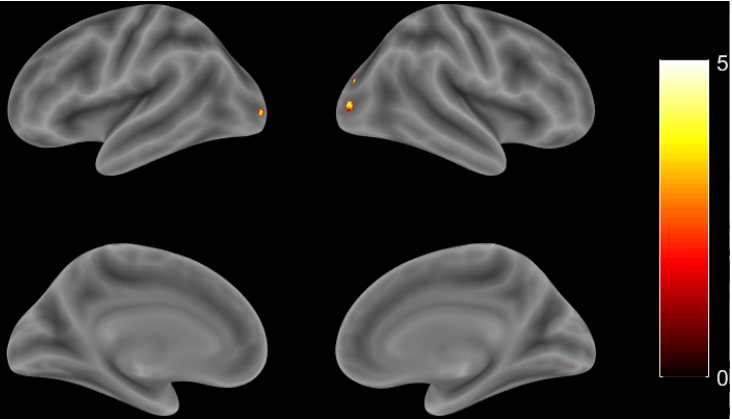
Figure 4. Whole brain activation patterns for HC compared the AD group ( p value < 0.001, uncorrected). Table 4. HC and AD group comparison of the activation of brain regions ( p value < 0.001, uncorrected). Region